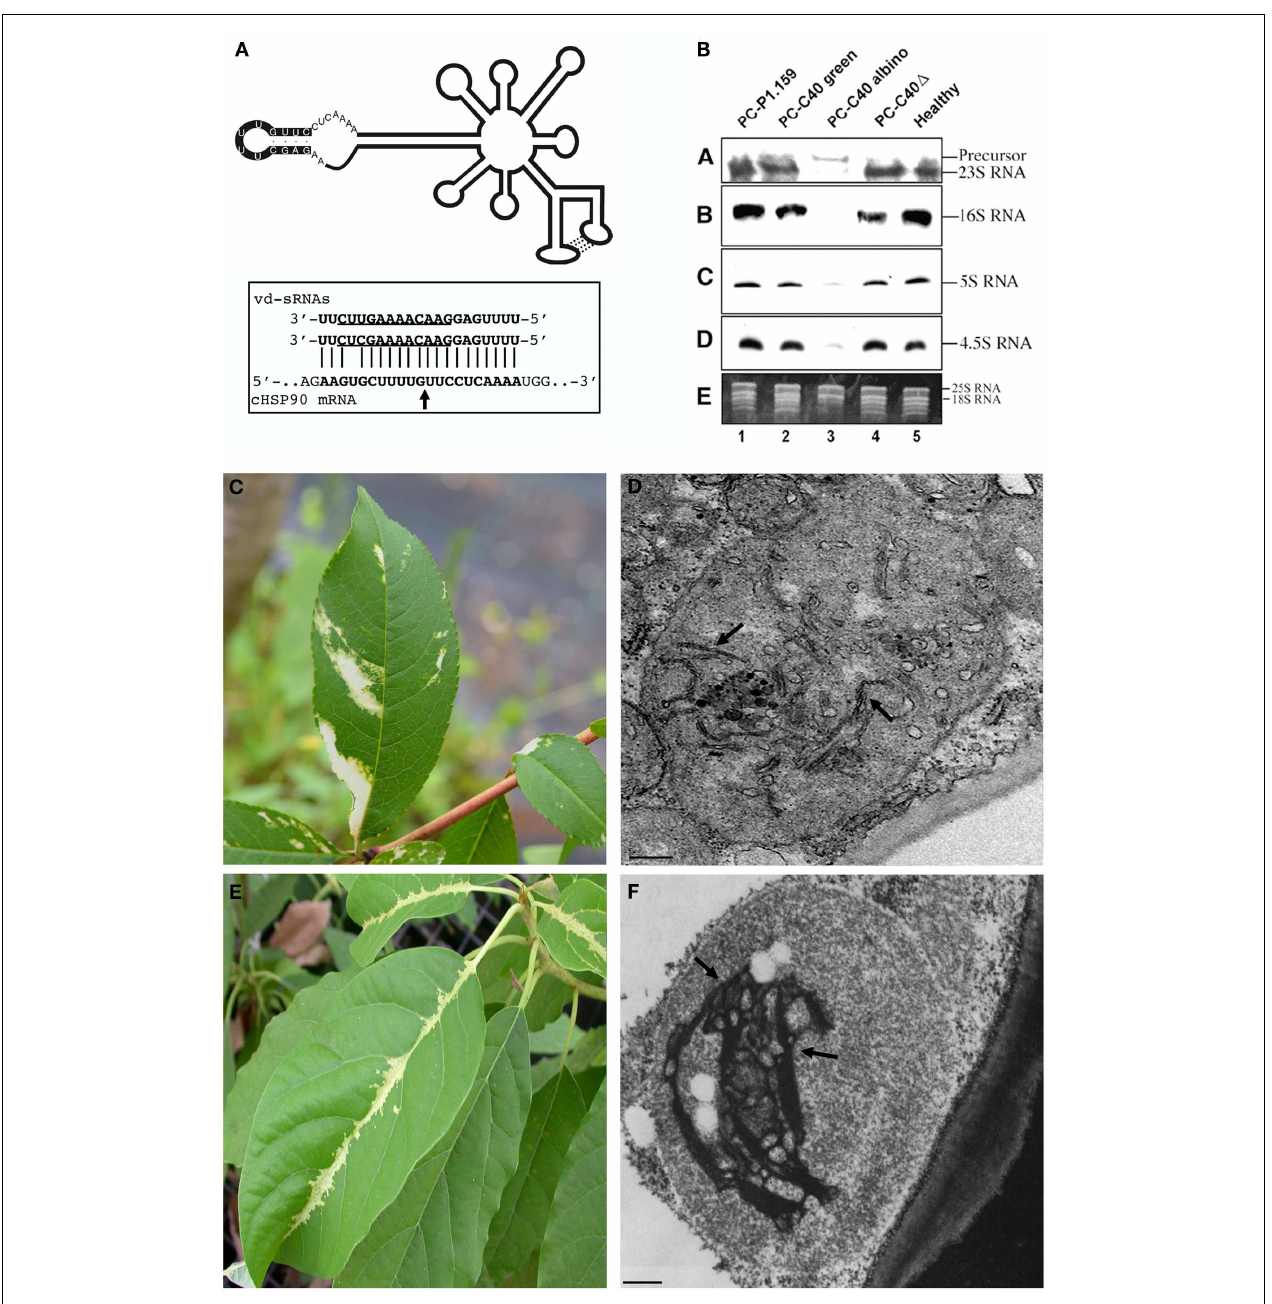
4.5S rRNAs; the impaired accumulation and processing of plastid rRNAs is associated with the albino phenotype (Rodio et al., 2007). (C) Severe chlorosis induced by a PC-inducing variant of PLMVd and (D) altered plastid with rudimentary thylakoid membranes (arrows) observed in chlorotic areas. (E) Severe chlorosis induced by ASBVd and (F) altered plastid with rudimentary thylakoid structures (arrows), slightly more organized than in PC, in the corresponding bleached areas. Bar = 50nm. (A,B,F) have been reproduced with permissions from Navarro et al., 2012b; Copyright John Wiley and Sons), Rodio et al., 2007; Copyright American Society of Plant Biologists, www.plantcell.org) and Da Graça and Martin (1981), respectively, in all cases with